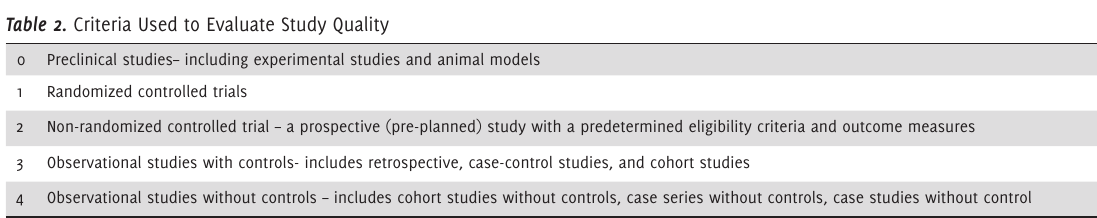
Figure 2. Flow Diagram for Article Selection PubMed Search "Ankylosing Spondylitis" + "Inflammatory Bowel Disease" + "HLA-B27 Antigen"